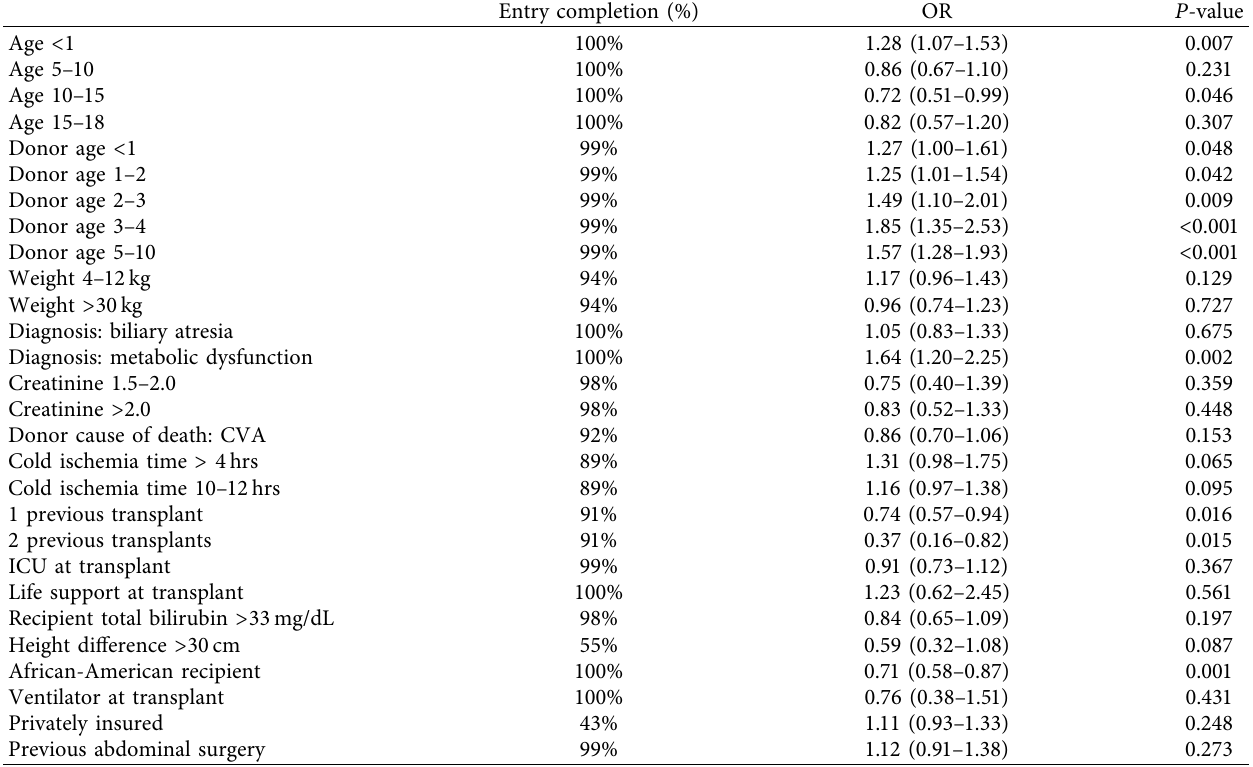
Table 2: Multivariate logistic regression for factors that predict 20-year survival in 1-year survivors.